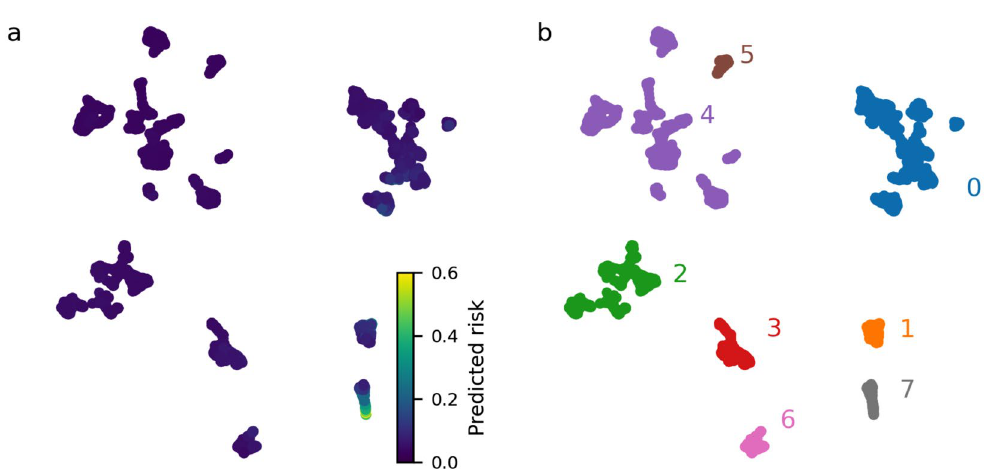
Figure 4. Embedding of the hold-out test set into a two-dimensional ‘explanation’ space using the UMAP algorithm. ( a ) All attendances in the hold-out test set visualised in the explanation space, colour indicates the predicted reattendance risk for the respective attendance. ( b ) Attendances in the explanation space coloured by cluster assignment. Cluster assignment was performed with the DBScan algorithm 28 . Assignment was chosen by visual inspection and finer grained cluster assignment can be achieved by tuning the hyperparameters of the DBScan algorithm. The explanation embedding was created by clustering the SHAP values (explanations) for each attendance using the UMAP algorithm. Closer data points share a more similar explanation for their predicted reattendance risk. Descriptive properties of each cluster are displayed in Table